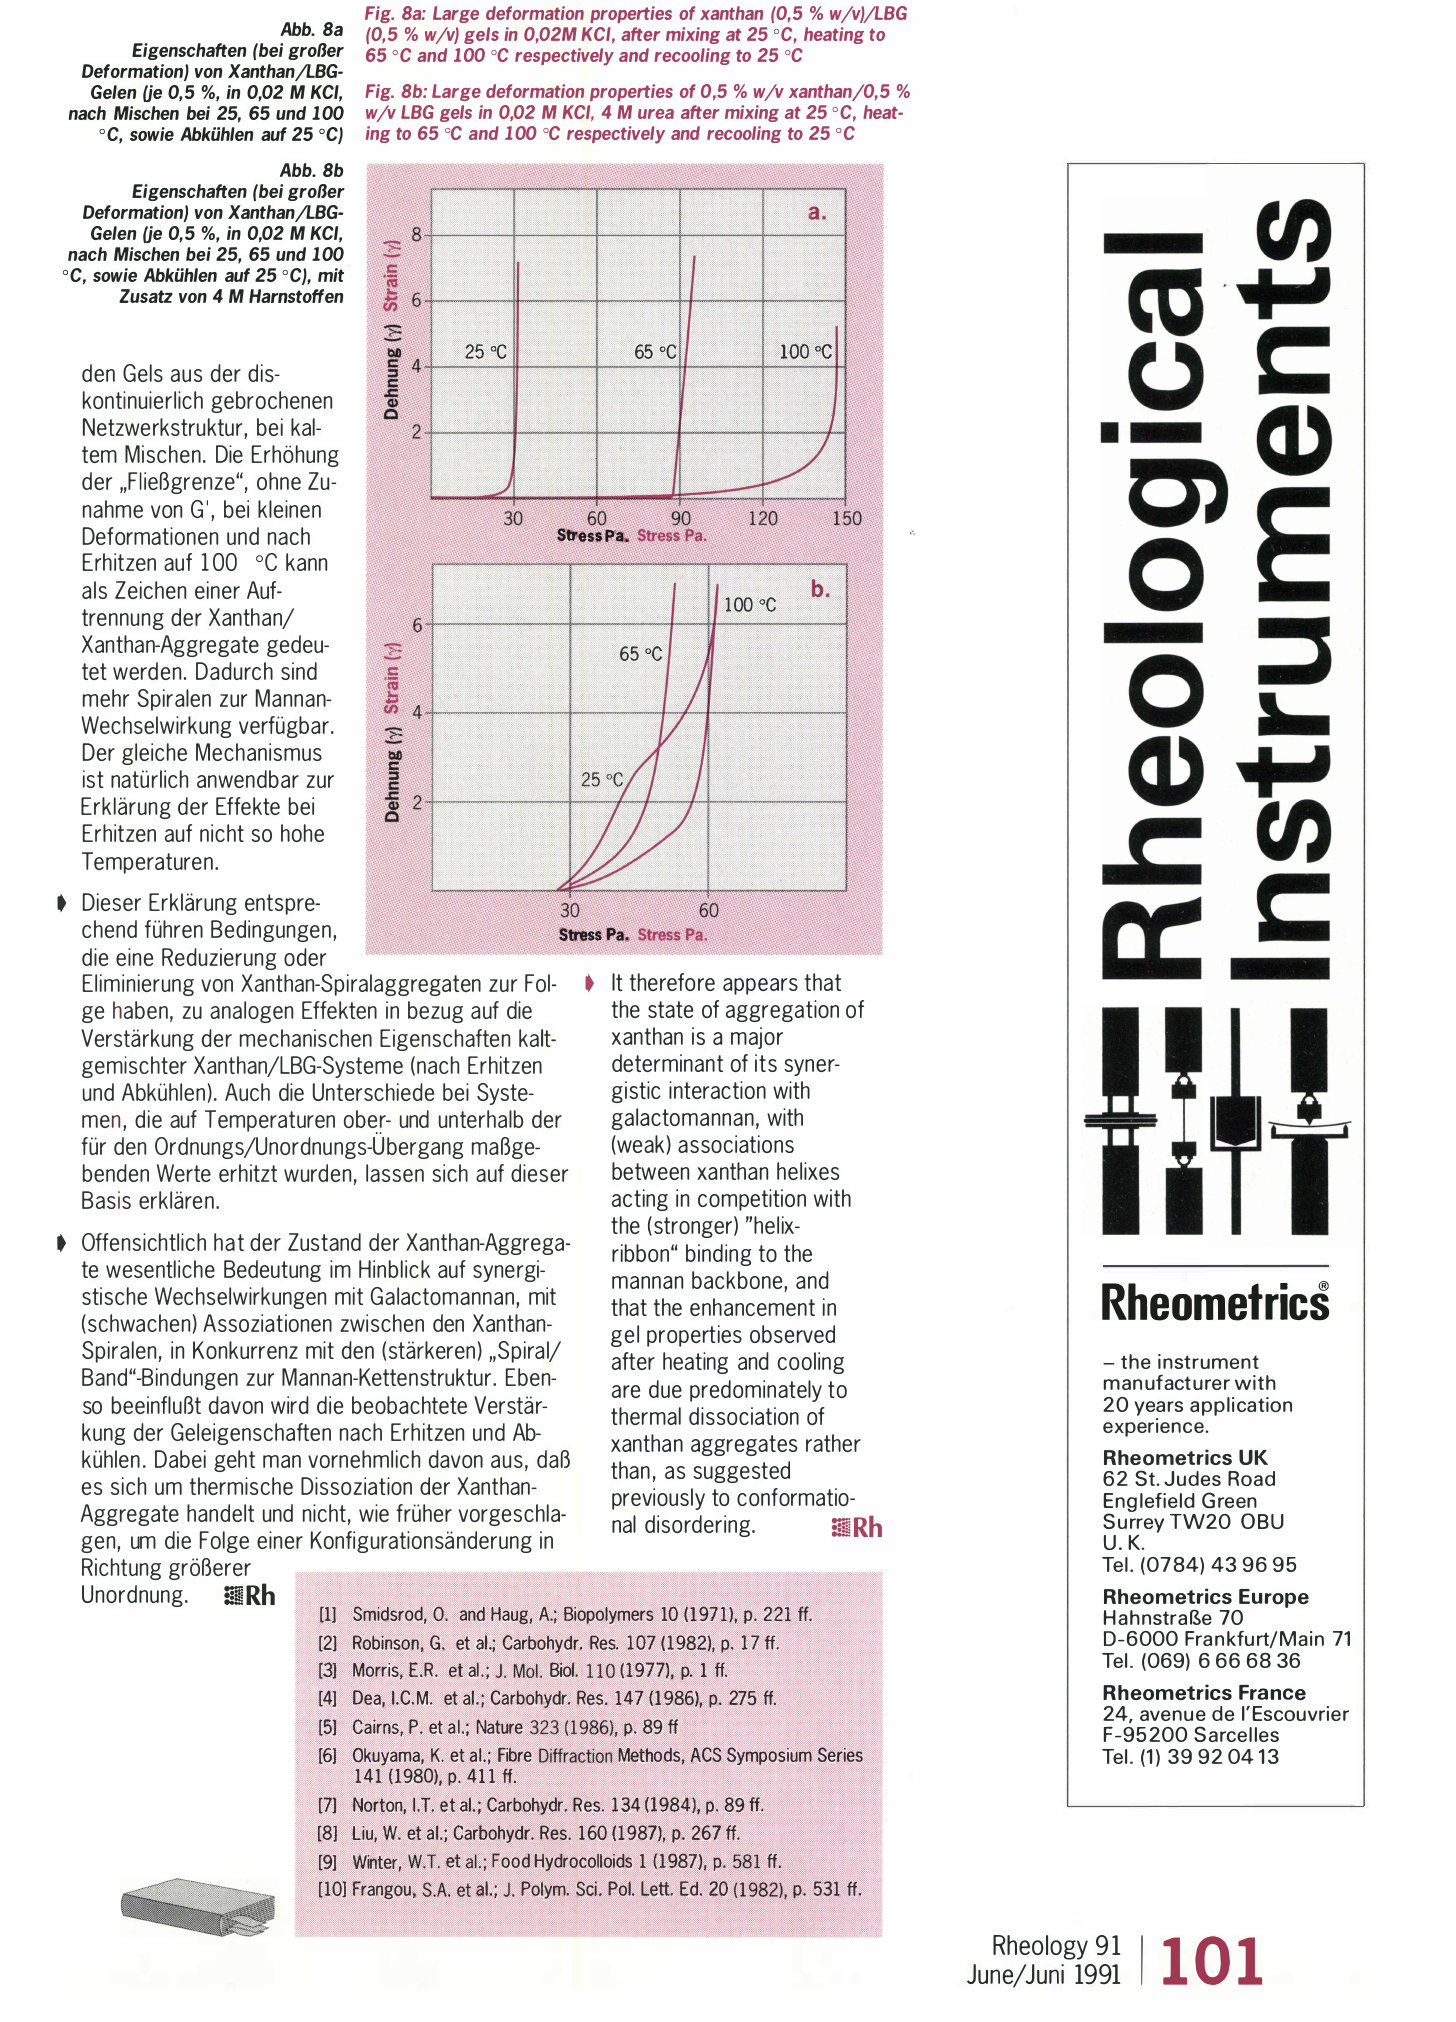
Fig. Ba: Large deformation properties of xanthan (0,5 % wjv]jlBG (0,5 % wjv] gels in 0,02M KCI, after mixing at 25 oc, heating to Fig. Bb: Large deformation properties of 0,5% wjv xanthan/0,5 % wjv LBG gels in 0,02 M KCI, 4 M urea after mixing at 25 oc, heat­ ing to 65 oc and 100 oc respectively and recooling to 25